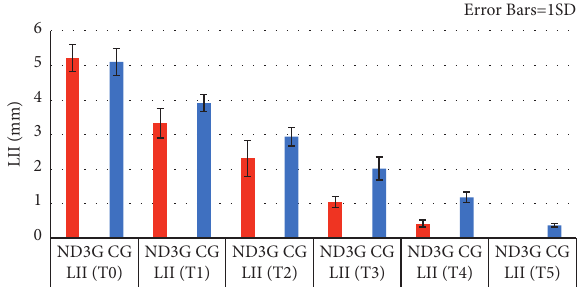
Figure 4: Amount of little irregularity index at various time interval.